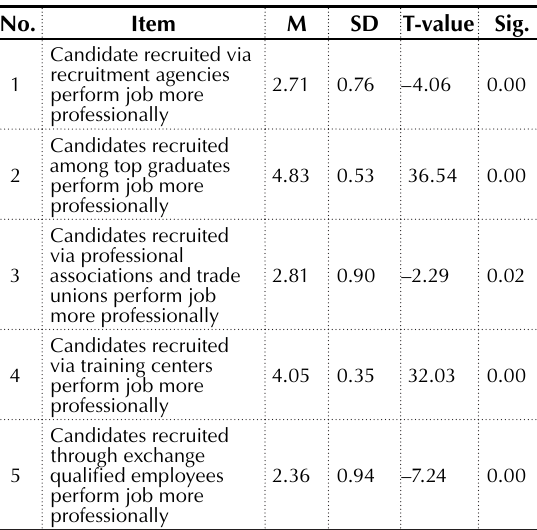
Table 5. Means, standard deviations,